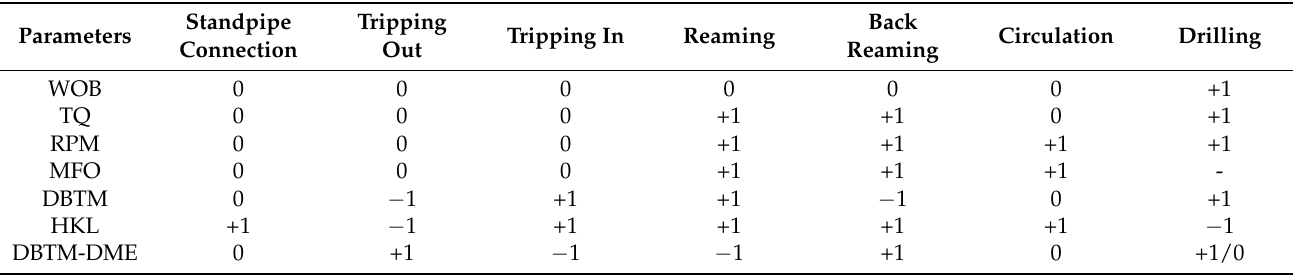
Table 2. Sample data change labeling